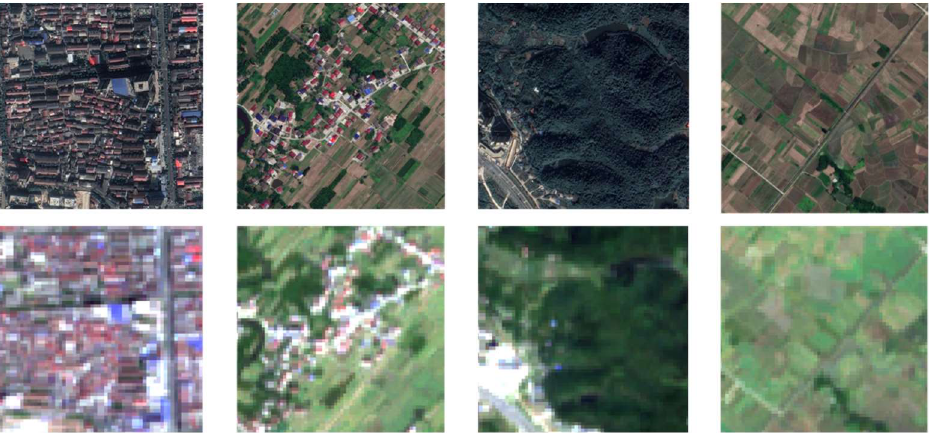
Figure 14. Ground truth labels. First row: ground truth labels in Google Maps; second row: ground truth labels in Sentinel-2 L2A RGB. Table 10. Test results of ground truth data and 10m land cover data.